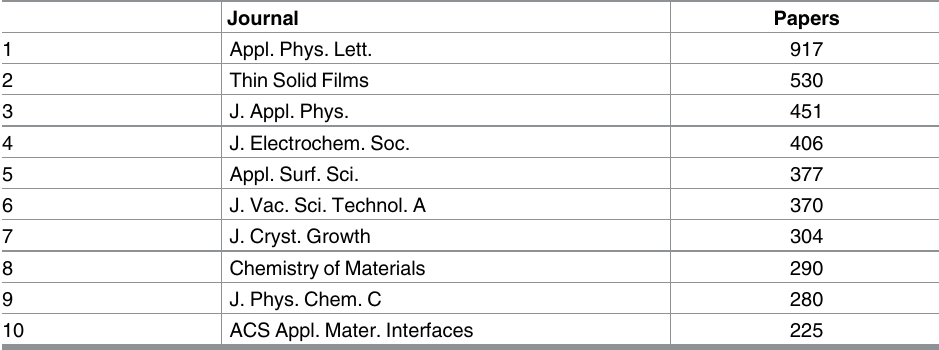
Table 1. Top 10 journals by the number of ALD papers published.